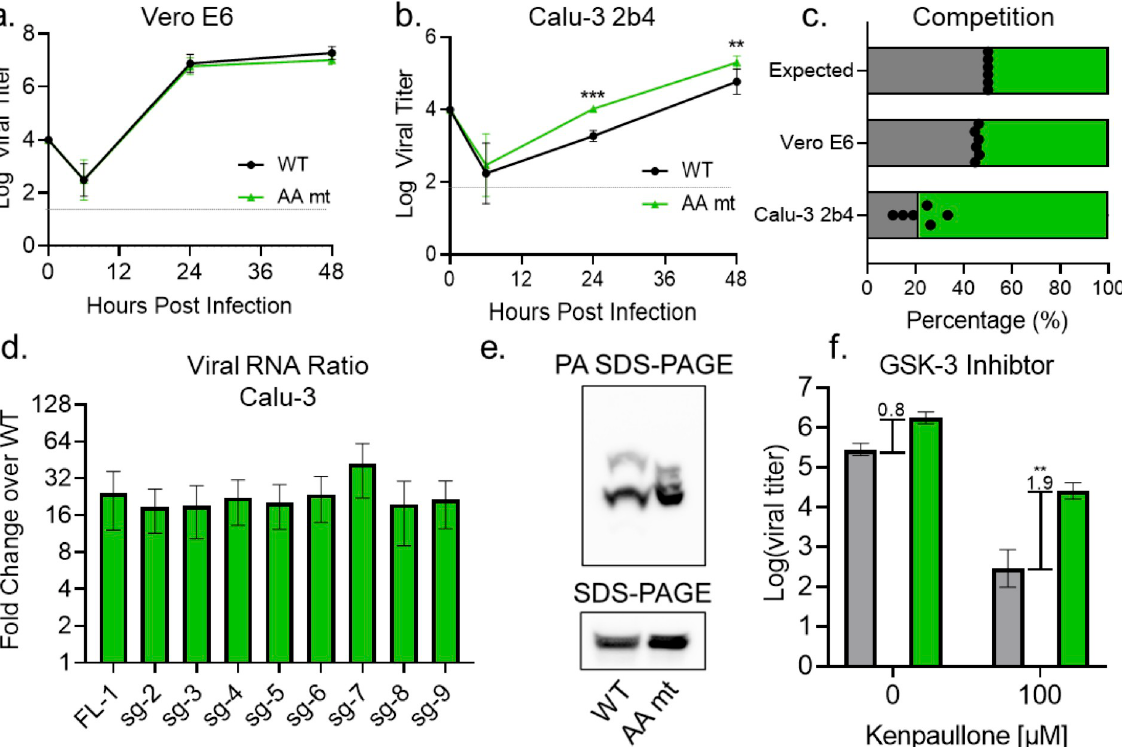
Fig 7. The AA mt mimics the KR mt’s enhancement of SARS-CoV-2 infection. ( A-B ). Viral titer from Vero E6 (A) or Calu-3 2b4 (B) cells infected at an MOI of 0.01 with WT (black) or the AA mt (green) (n = 9). ( C ) Competition assay between WT (gray) and the AA mt (green) in Vero E6 and Calu-3 2b4 cells at a 1:1 input ratio and an MOI of 0.01 (n = 6). ( D ) Full-length and subgenomic transcript levels 24 hours post infection from Calu-3 2b4 cells infected with WT or the AA mt. Transcripts were normalized to 18S ribosomal RNA and graphed as fold change in the AA mt relative to WT (n = 3). ( E ) Whole cell lysates from Calu-3 2b4 cells infected with WT or the AA mt and analyzed by PA SDS-Page (top) and standard SDS-Page (bottom) followed by blotting with an N-specific antibody (n = 3). ( F ) Viral titer 48 hours post infection from Calu-3 2b4 cells infected with WT (gray) or the AA mt (green) at an MOI of 0.01. Cells were treated with the indicated concentrations of kenpaullone prior to and during infection (n = 4). Brackets and numbers indicate the mean log-titer difference between WT and the KR mt. Bars represent mean titer ± s.d. Significance was determined by two-tailed student’s t-test with p � 0.01 ( �� ) and p � 0.001 ( ��� ). Grey dotted lines are equal to LOD.